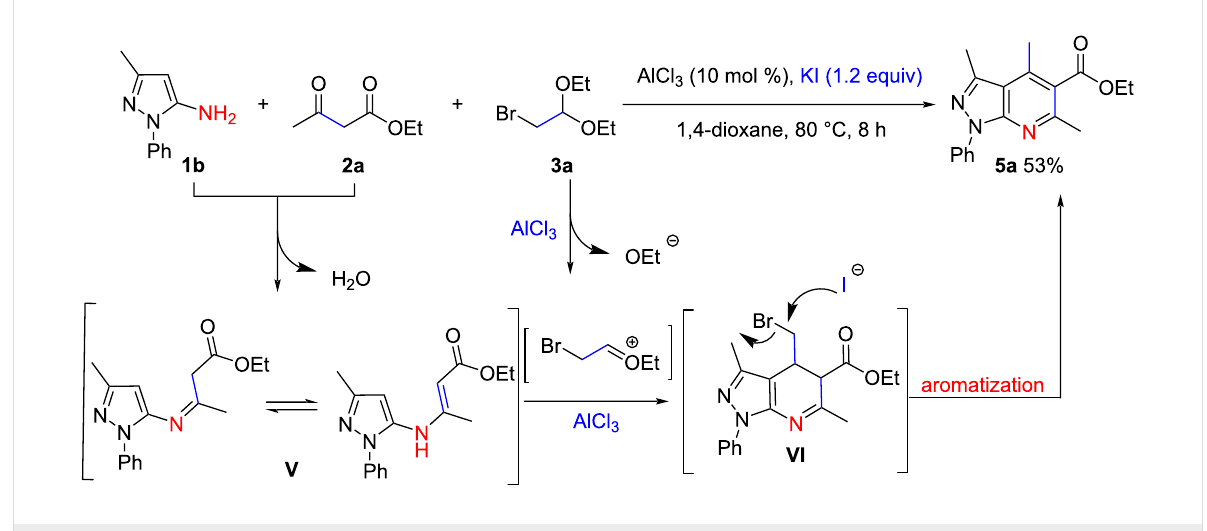
Scheme 6: Synthesis of polysubstituted pyrazolo[3,4-b]pyridine